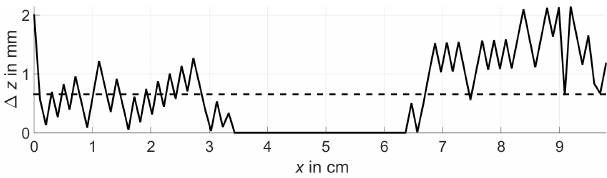
Figure 7. Estimation error (cid:49)z for the material boundary. Dashed line: mean